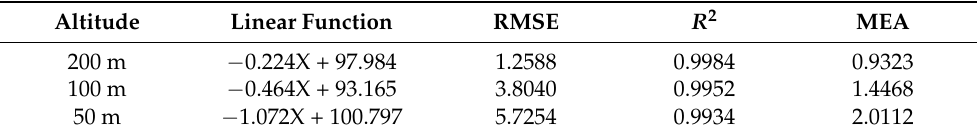
Table 1. The effect of a drone’s altitude on the performance; the results are presented for location #1 and various altitudes, with a drone speed of 5 m/s (18 km/h).